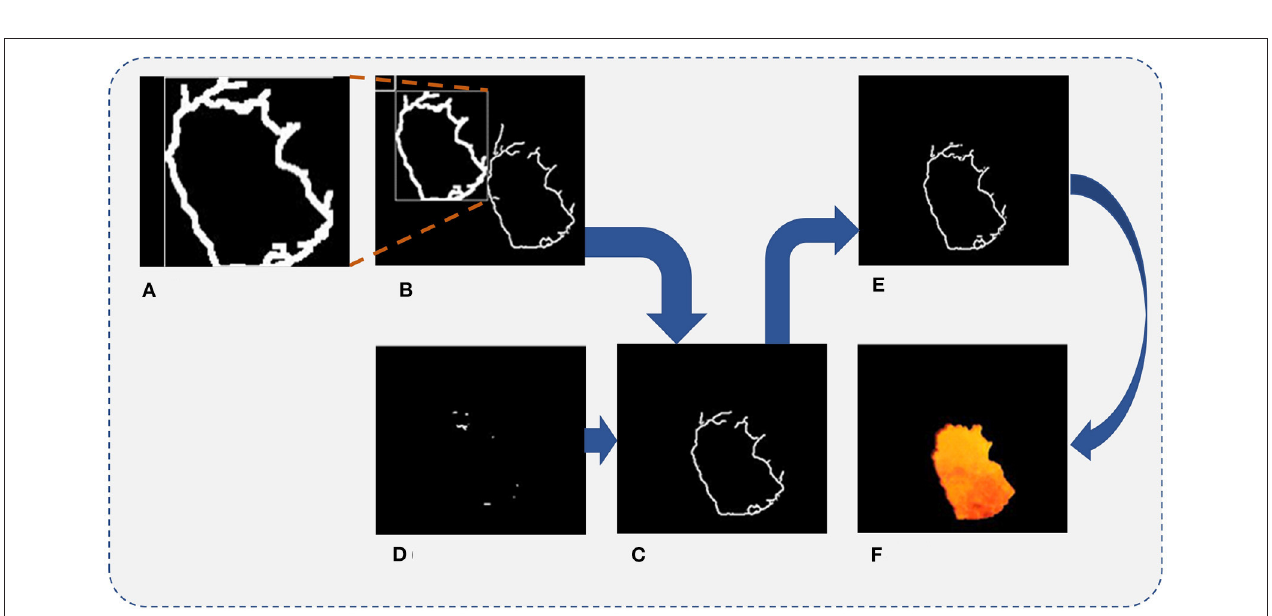
FIGURE 5 | Final separated result of the fire hole. (A) The processed previous frame edge image. (B) Matching diagram of the edge image. (C) The overlapped part of the two images. (D) The missing part of the next frame image. (E) The continuous edge feature image. (F) Final separated result of the fire hole.